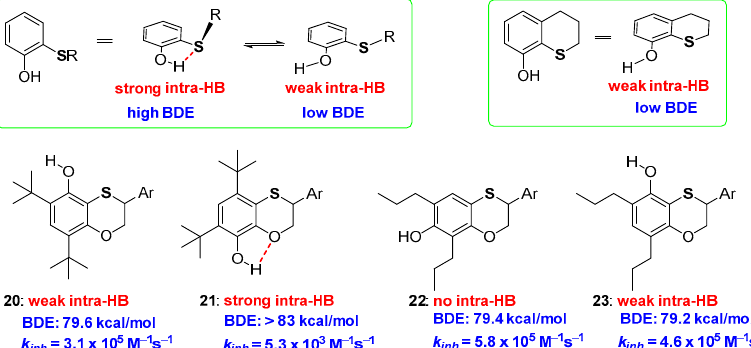
Figure 7. Conformational and substitution considerations on intra-HB strength of acyclic and cyclic ortho -thioalkyl substituted phenols, and benzoxathiines 20–23 prepared to quantify the role of this phenomenon on k inh and ArO-H BDE.